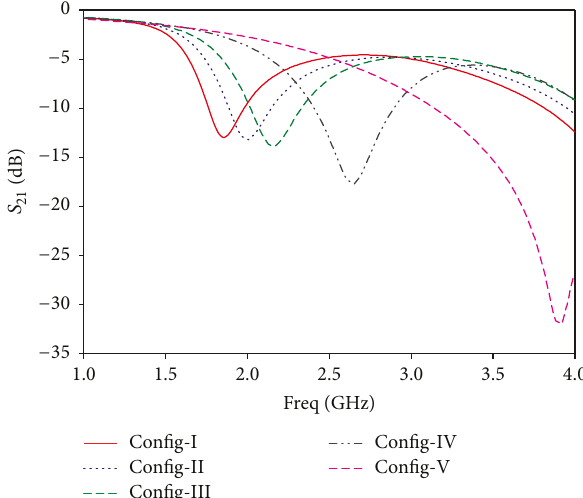
Figure 7: Resonance frequency variation for different slot lengths.